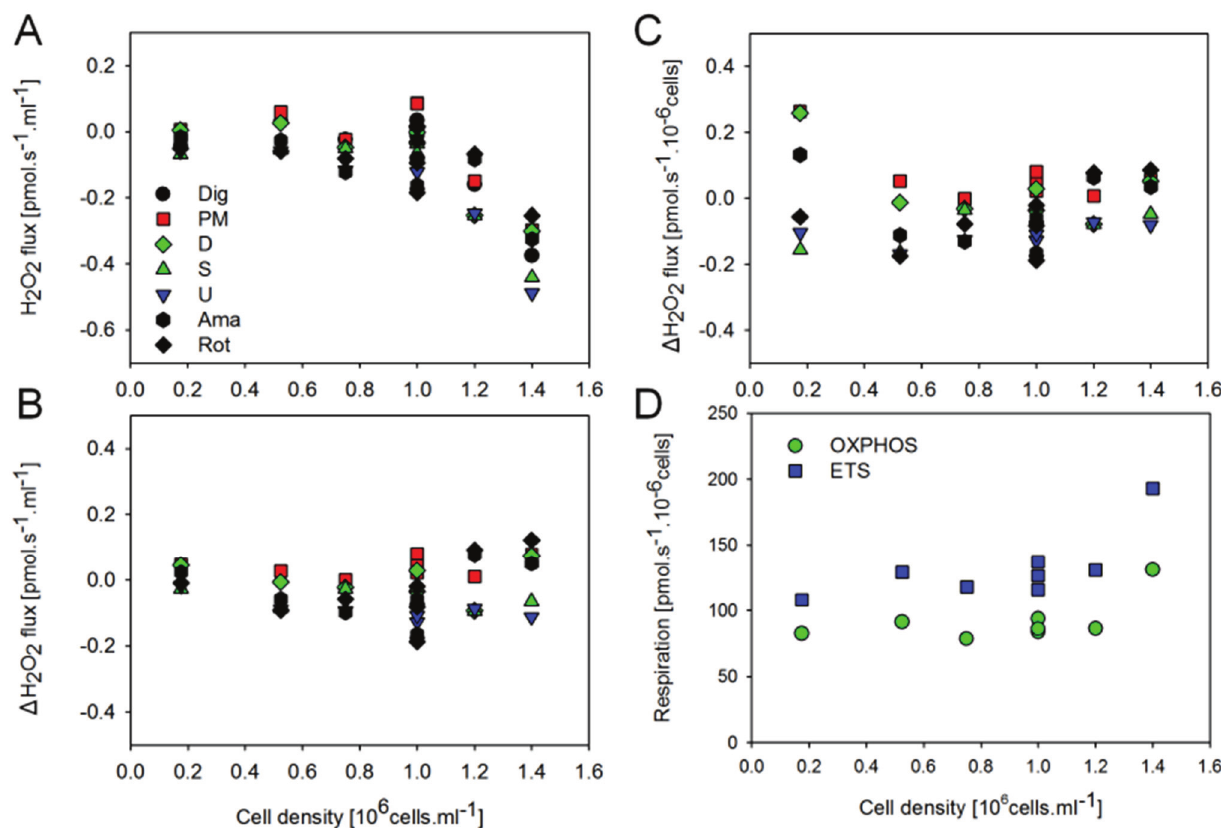
Figure 5. Effect of cell concentration in the O2k-chamber on H 2 O 2 flux and respiration of permeabilized HEK 293T cells. ( A ) H 2 O 2 flux (per O2k-chamber volume) corrected for